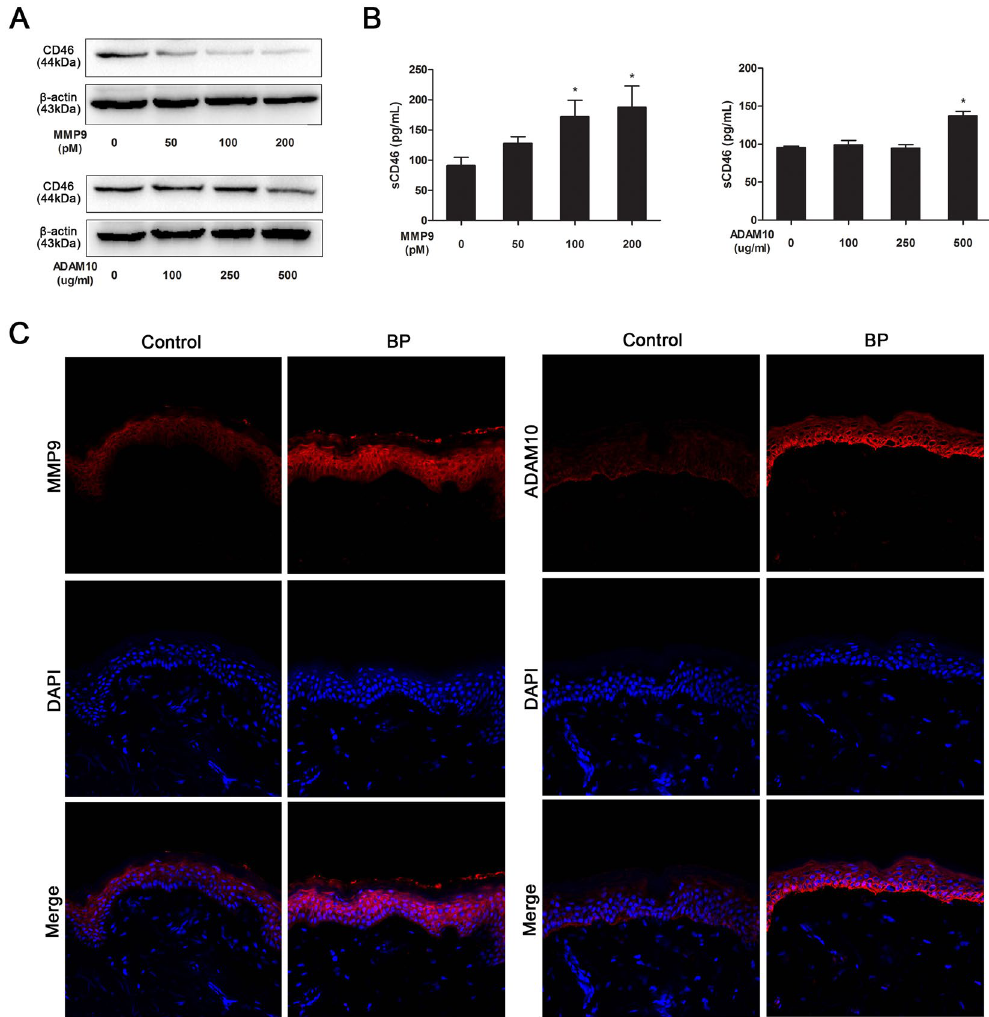
Figure 5. MMP9 and ADAM10 are responsible for shedding of mCD46 in BP pathogenesis. HaCaT cells were incubated with activated MMP9 (50, 100 and 200 pM) and ADAM10 (100, 250 and 500 ng/mL) proteinases at 37 °C for 2 h. ( A ) The HaCaT cells were collected and CD46 were detected by western blot after incubation. ( B ) Elisa assay were used to value the sCD46 in the supernatant that shedded by MMP9 and ADAM10. Results represent the mean ± SEM from three independent experiments. P < 0.05 was considered significant. ( C ) IF staining was performed on normal skin sections and lesions from BP patient measure MMP9 and ADAM10 expression in the epidermal keratinocytes. DAPI staining of nuclei is shown in blue. Scale bar, 100